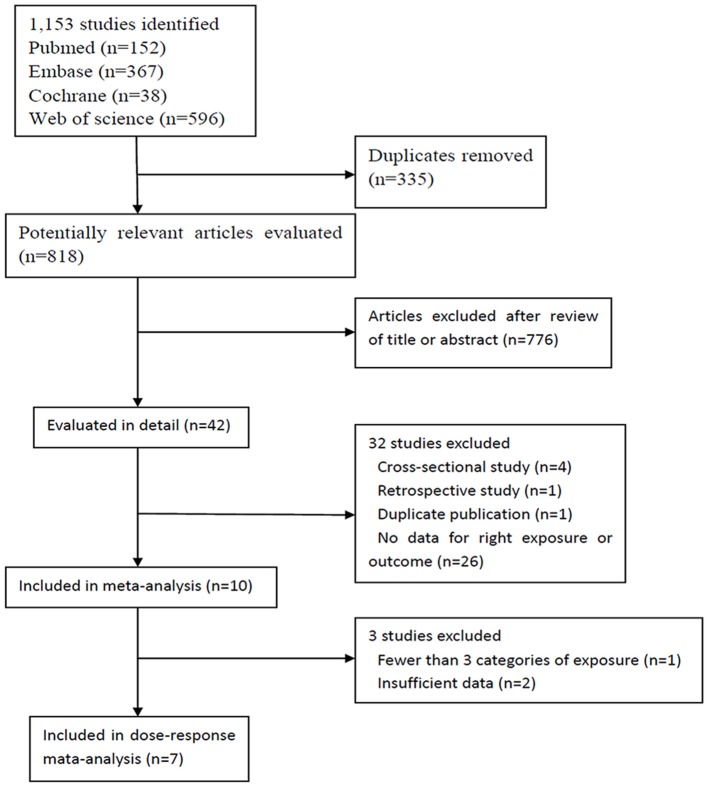
Flow chart of study selection.